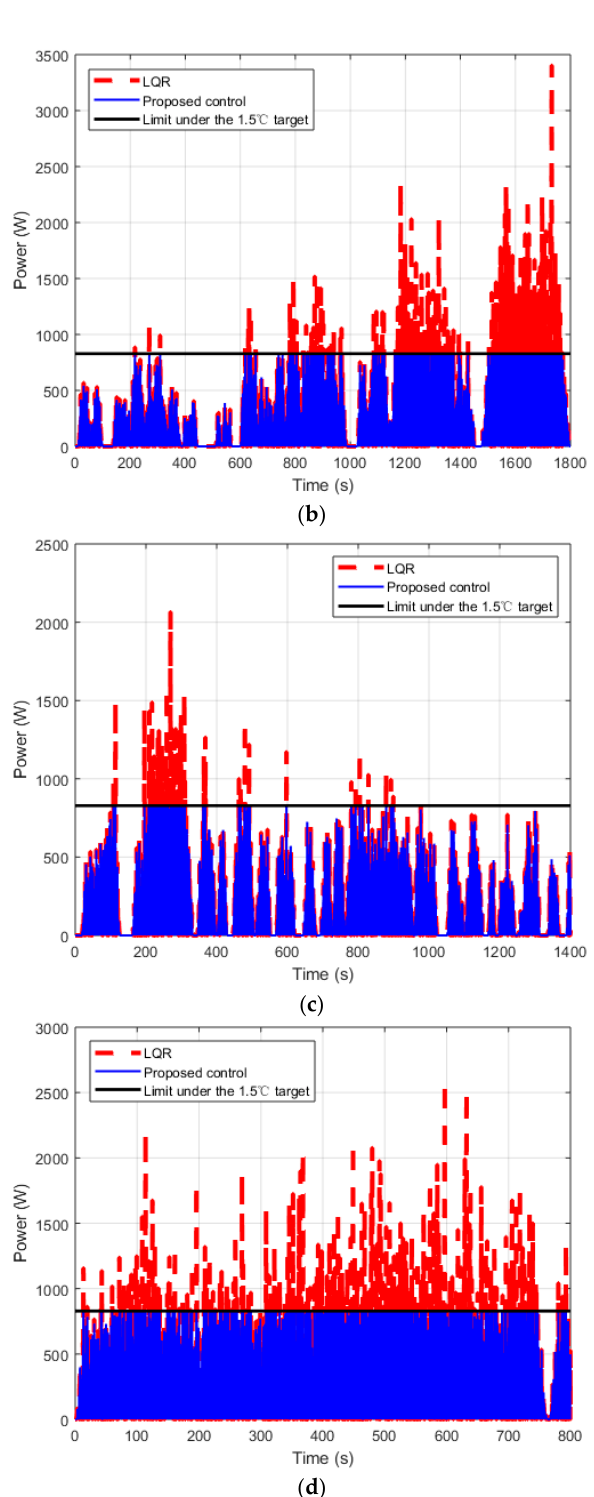
Figure 7. Power consumption comparison between different scenarios. ( a ) Scenario 1; ( b ) Scenario 2; ( c ) Scenario 3; ( d ) Scenario 4.